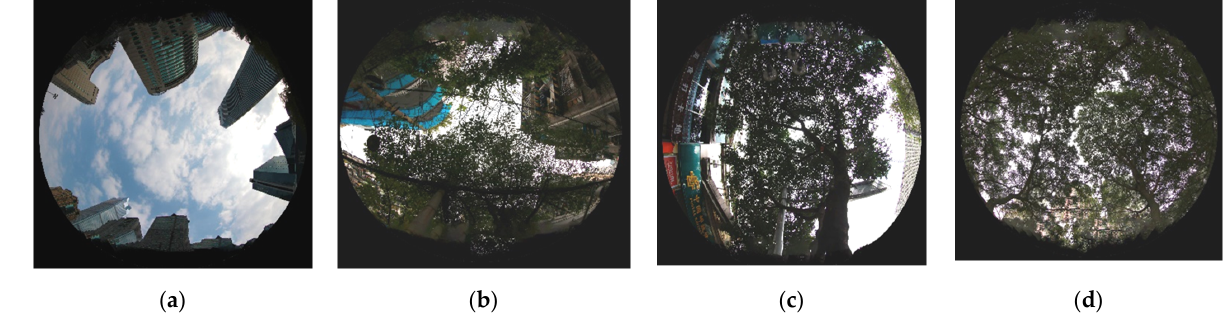
Figure 3. Representative sky fisheye photos of the four measurement areas: ( a ) is the Jiefangbei measurement point; ( b ) is the Dajing Lane measurement point; ( c ) is the People’s Park measurement point; ( d ) is the Riverside Park measurement point.